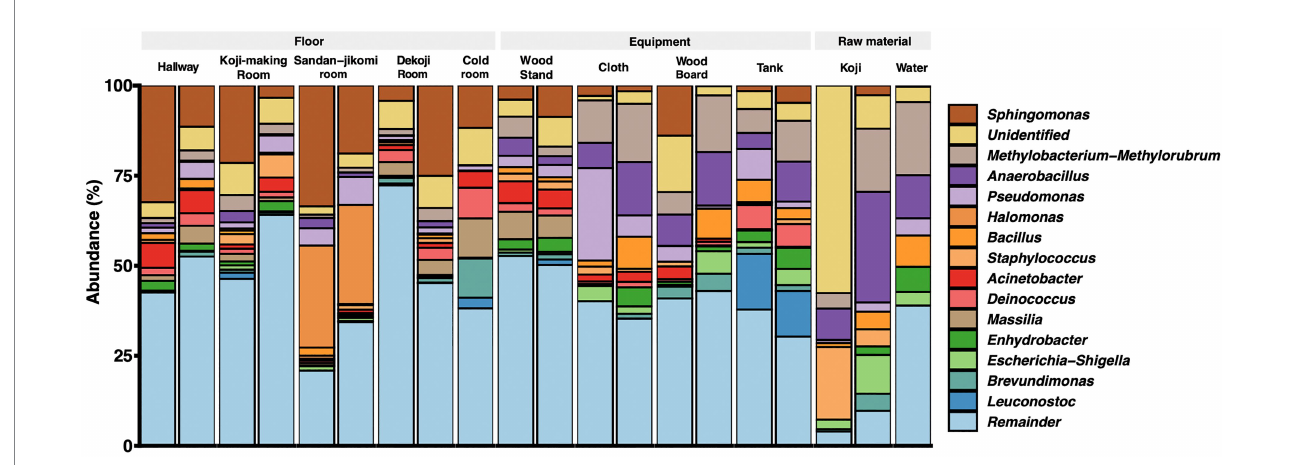
FIGURE 3 Genus-level taxonomic composition across the environmental